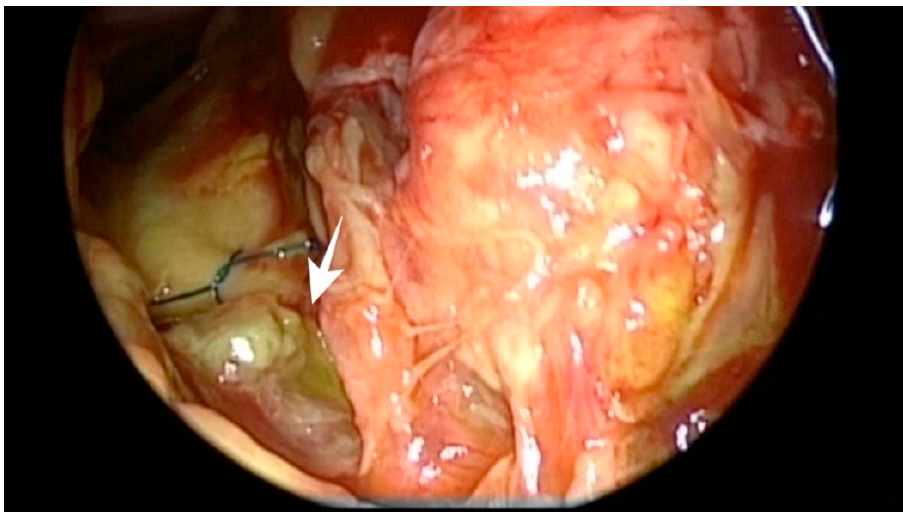
Figure 3. Endoscopic view of a CSF leak on the posterior wall of the frontal sinus, adjacent to the previous cranialization suture; white arrow points at the topic fluorescein shifting green in contact with CSF fluid (patient no. 12).